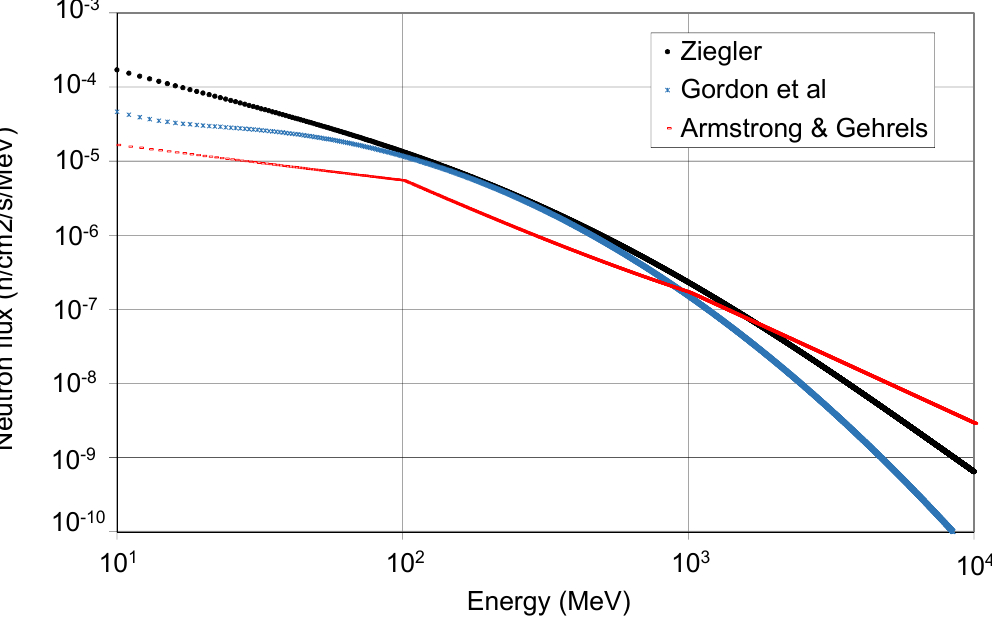
Figure 2. Differential neutron flux as derived from parameterizations at sea level by Armstrong and Gehrels [48,49], Ziegler [50], and Gordon et al.